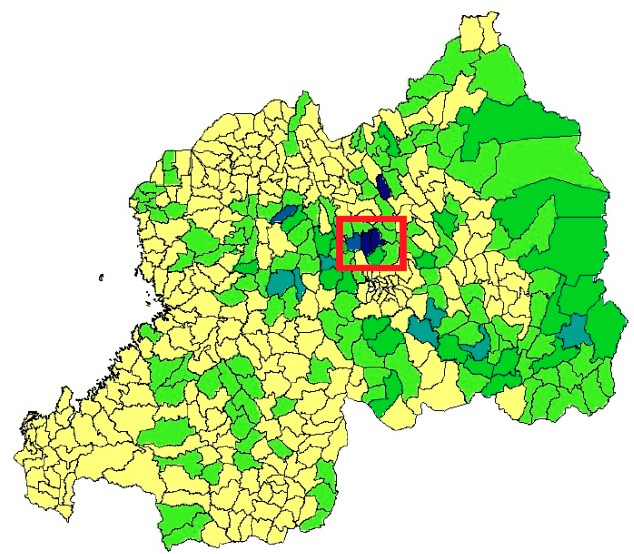
Figure 6. Location of the Case Studies Conducted. Yellow regions represent low rates of SHS penetration, while the green regions represent higher rates of penetration. The dark blue color symbolizes places where SHSs are widely popular. The red square on the map indicates location of the case studies conducted.